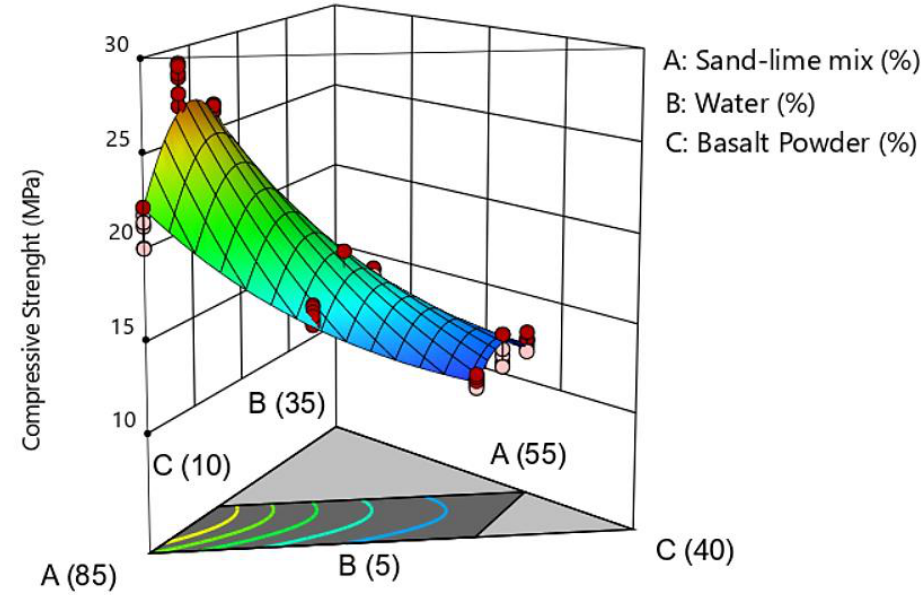
Figure 6. Compressive strength test sample.